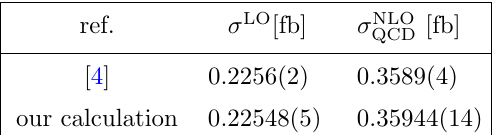
, of the process pp ! QCD